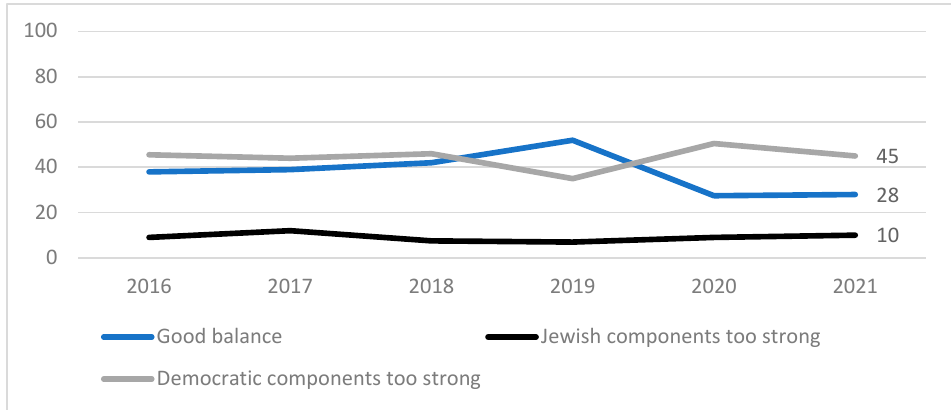
Figure 7. Feel that there is a good balance today between the Jewish and the democratic components of the state of Israel (%, RZS) ( Source: Israeli Democracy Index, 2016 ‒ 2021 ).